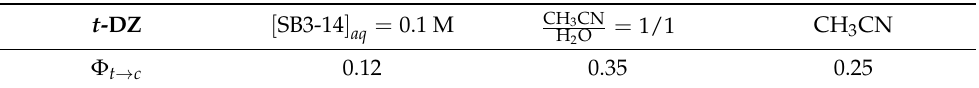
Table 5. Photochemical quantum yields Φ t → c for t -DZ in the three media. The relative uncertainties in the Φ t → c values are of the order of